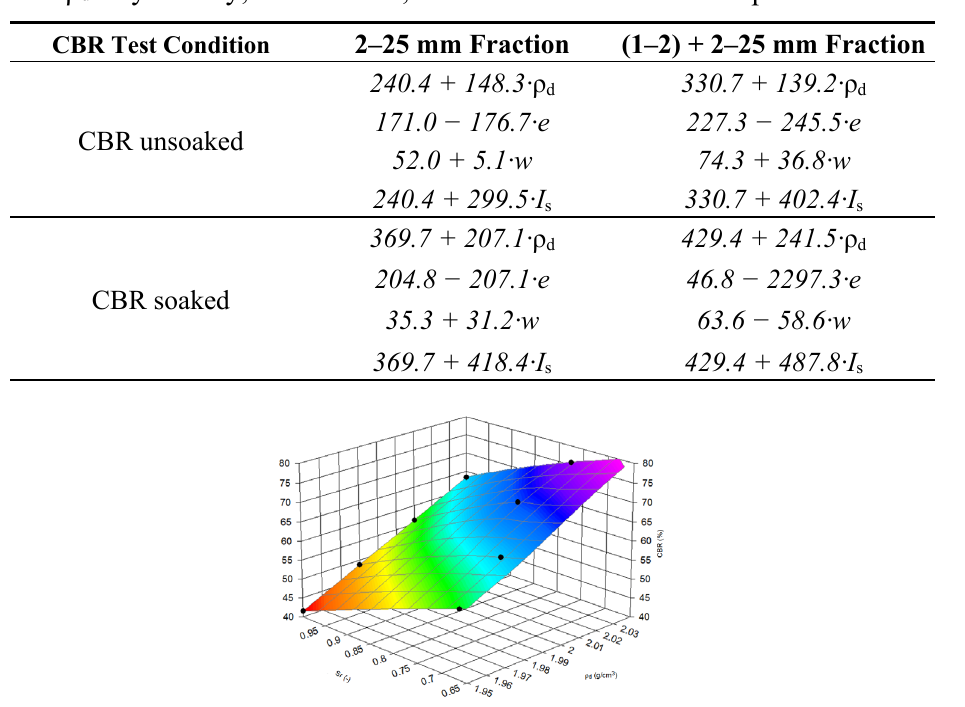
Table 3. Results of statistical correlation estimation from California bearing ratio (CBR) test results. ρ d : dry density; e : void ratio; w : moisture I s: relative compaction.